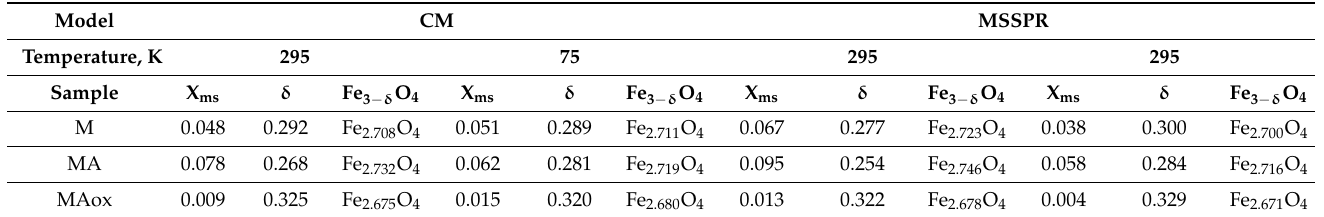
Table 4. Nonstoichiometry parameters of samples according to Mössbauer spectroscopy